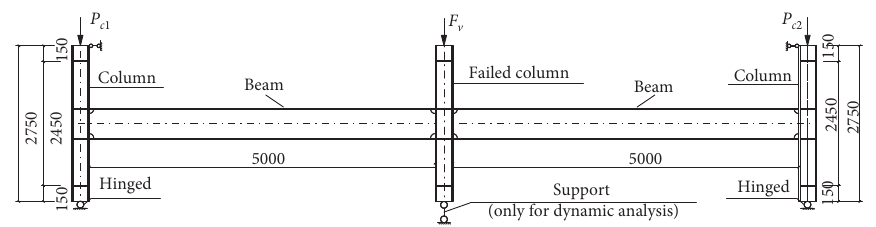
Figure 11: Computational model of the beam-column assembly (length unit: mm).